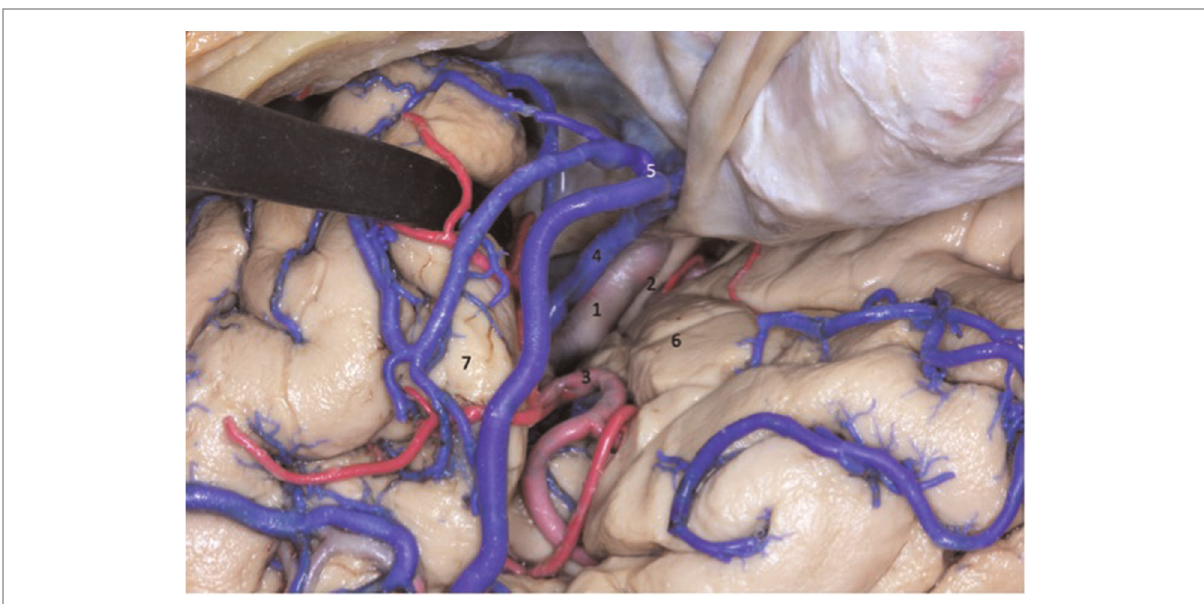
FIGURE 5 The deep portion of the sylvian fi ssure is divided into a sphenoid compartment, close to the limen insula, before the sphenoid crest, and another compartment called the insular operculum, formed by two narrow slits: opercular and insular. 1 - internal carotid artery; 2 - optic nerve; 3 -